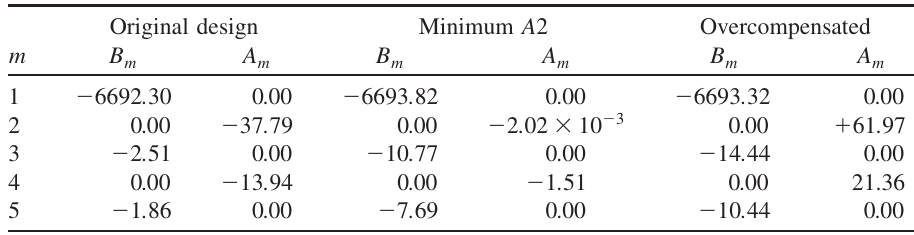
TABLE III. Harmonic amplitudes (in G) in three different shim cross sections.